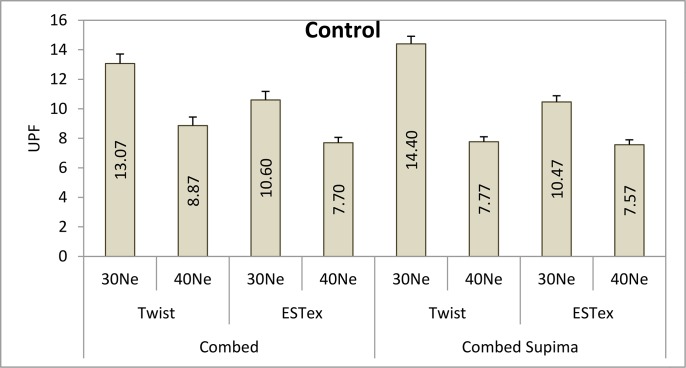
UPF values of various control fabrics (without dyeing).